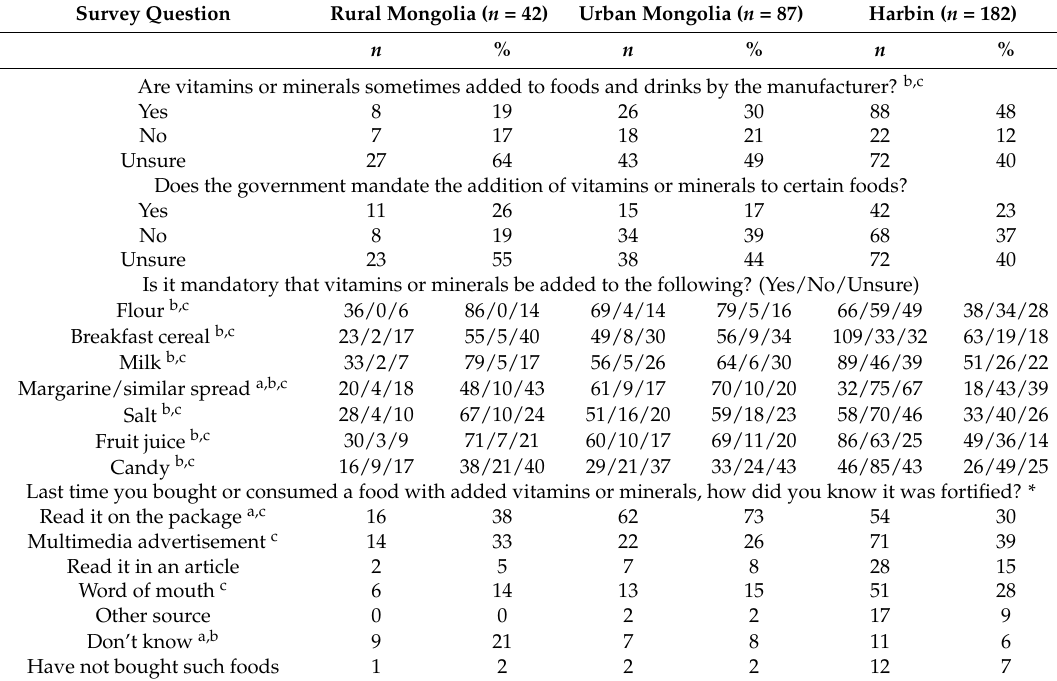
Table 2. Awareness of food